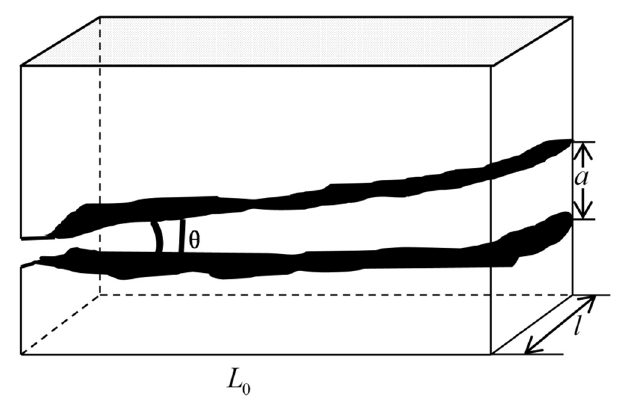
Figure 2. Model characterization of a single